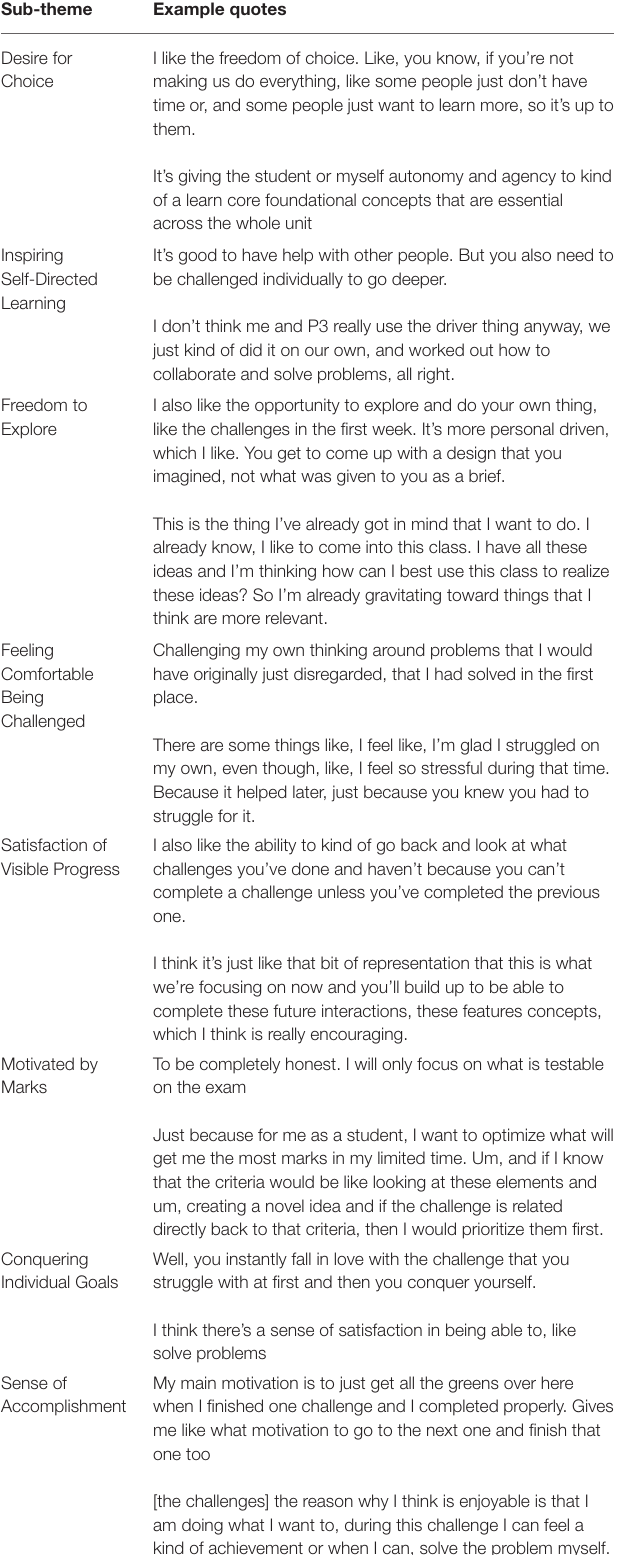
TABLE 3 | Sub-themes within the “Learner Autonomy”